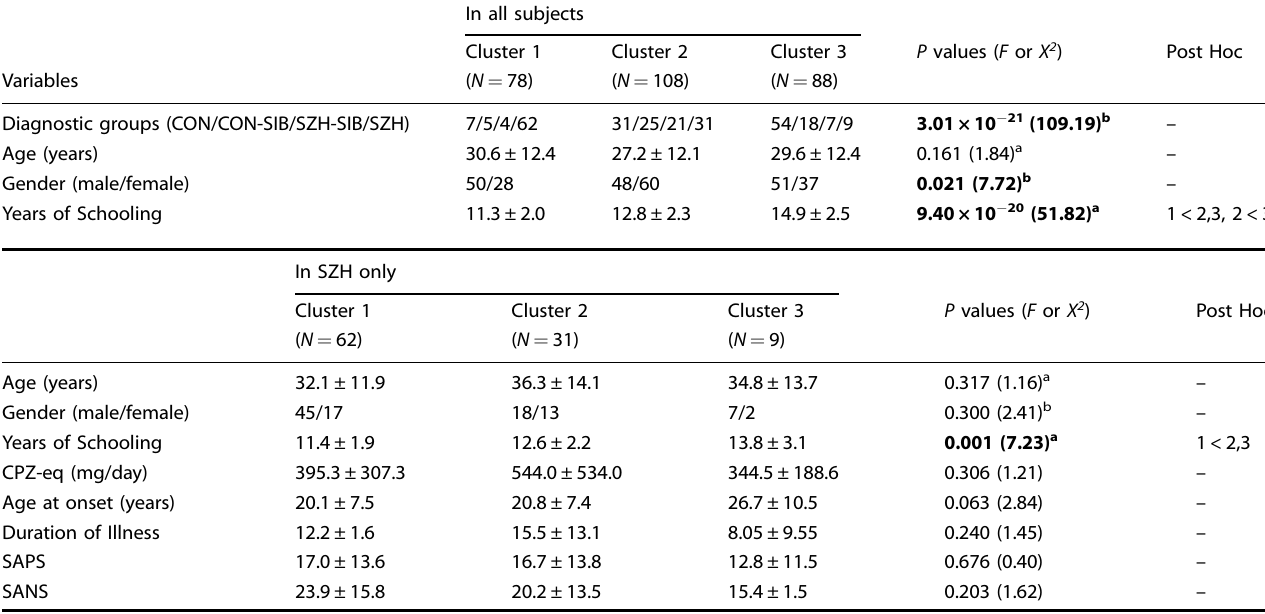
Table 1. Demographic characteristics of the sample by cluster groups, In all subjects, and in SZH only.